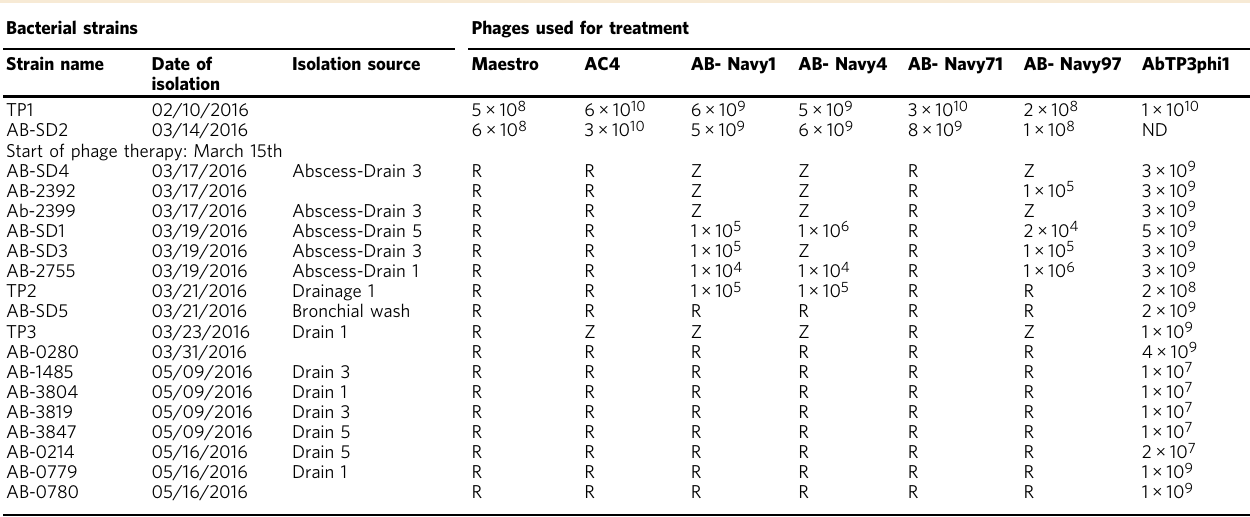
Table 2 Phage sensitivity of A. baumannii isolated from the patient before and during phage therapy. Bacterial strains Phages used for